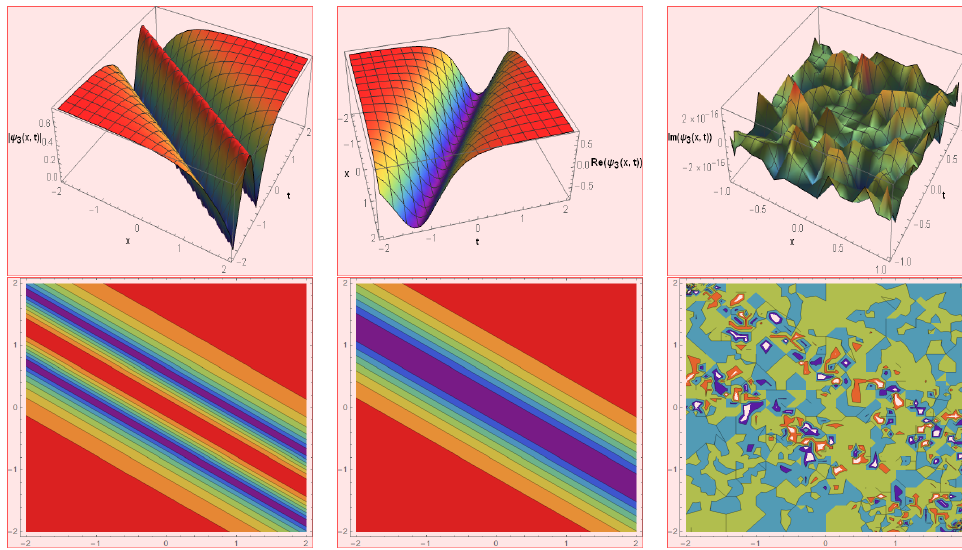
Figure 11. The absolute, real, and imaginary behavior in the shape of 3D and their corresponding contour plots are dispatched for ψ 3 ( x , t ) .